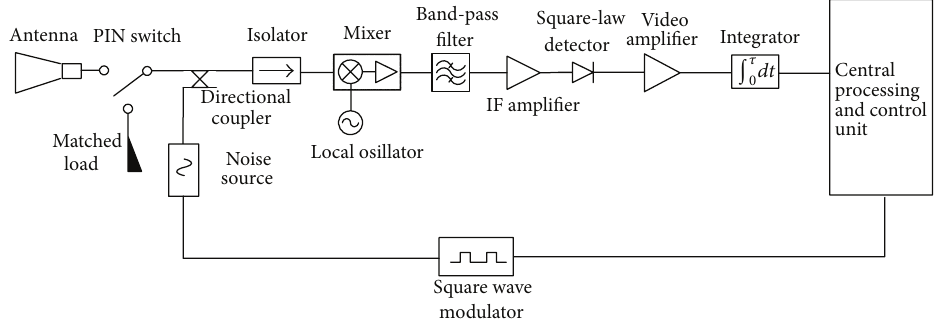
Figure 3: Illustration of the receiver block diagram.